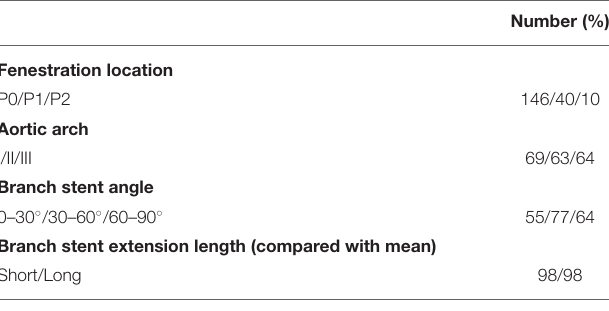
TABLE 2 | Follow-up computed tomographic angiography (CTA) data of the patients.